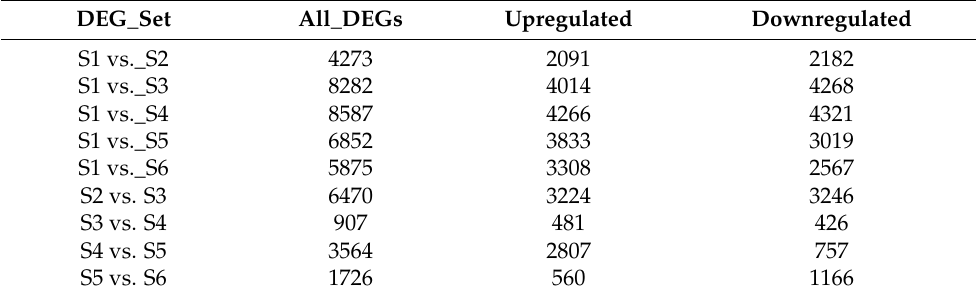
Table 3. Numbers of differentially expressed genes in the xylem sample comparisons. DEGs: differ- entially expressed